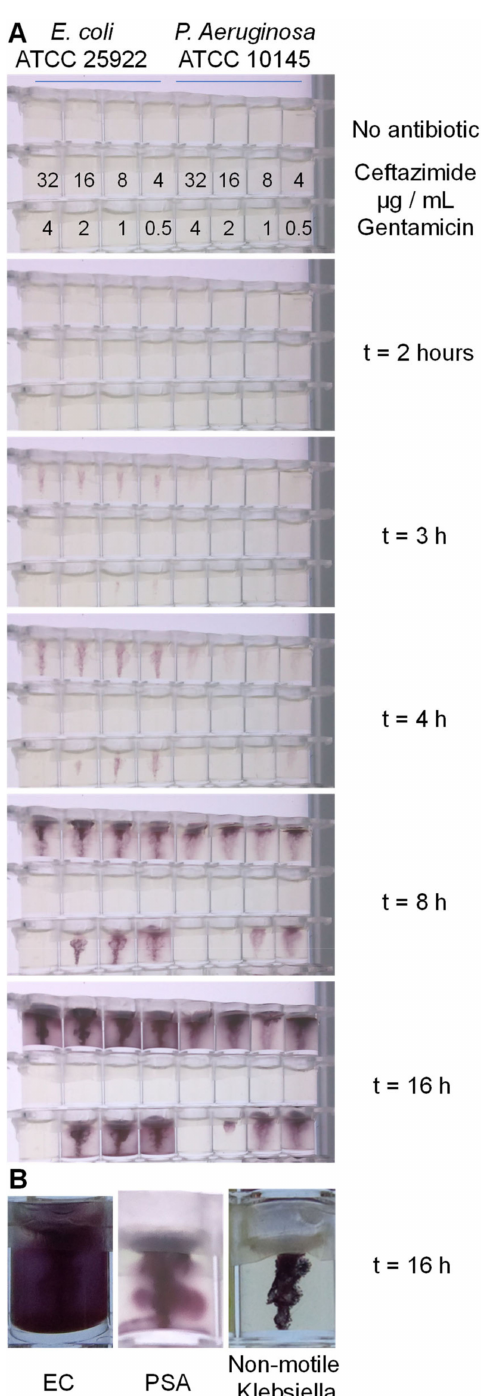
Figure 3. Confirming motility is inhibited by antibiotics using a combination of conventional methods. ( A ) Soft agar containing the indicated antibiotic concentrations was stabbed with an inoculum of the indicated motile bacteria, and time-lapse images recorded during overnight incubation. Dark staining by bacteria migrating away from the stab site become clear from 3 h, with spread across the whole well visible by 8–16 h; in contrast, antibiotics above the inhibitory concentration block migration and growth. ( B ) Close-up of endpoint images of motile E. coli and P. aeruginosa contrast with K. pneumoniae. Similar observations were seen in at least 5 independent